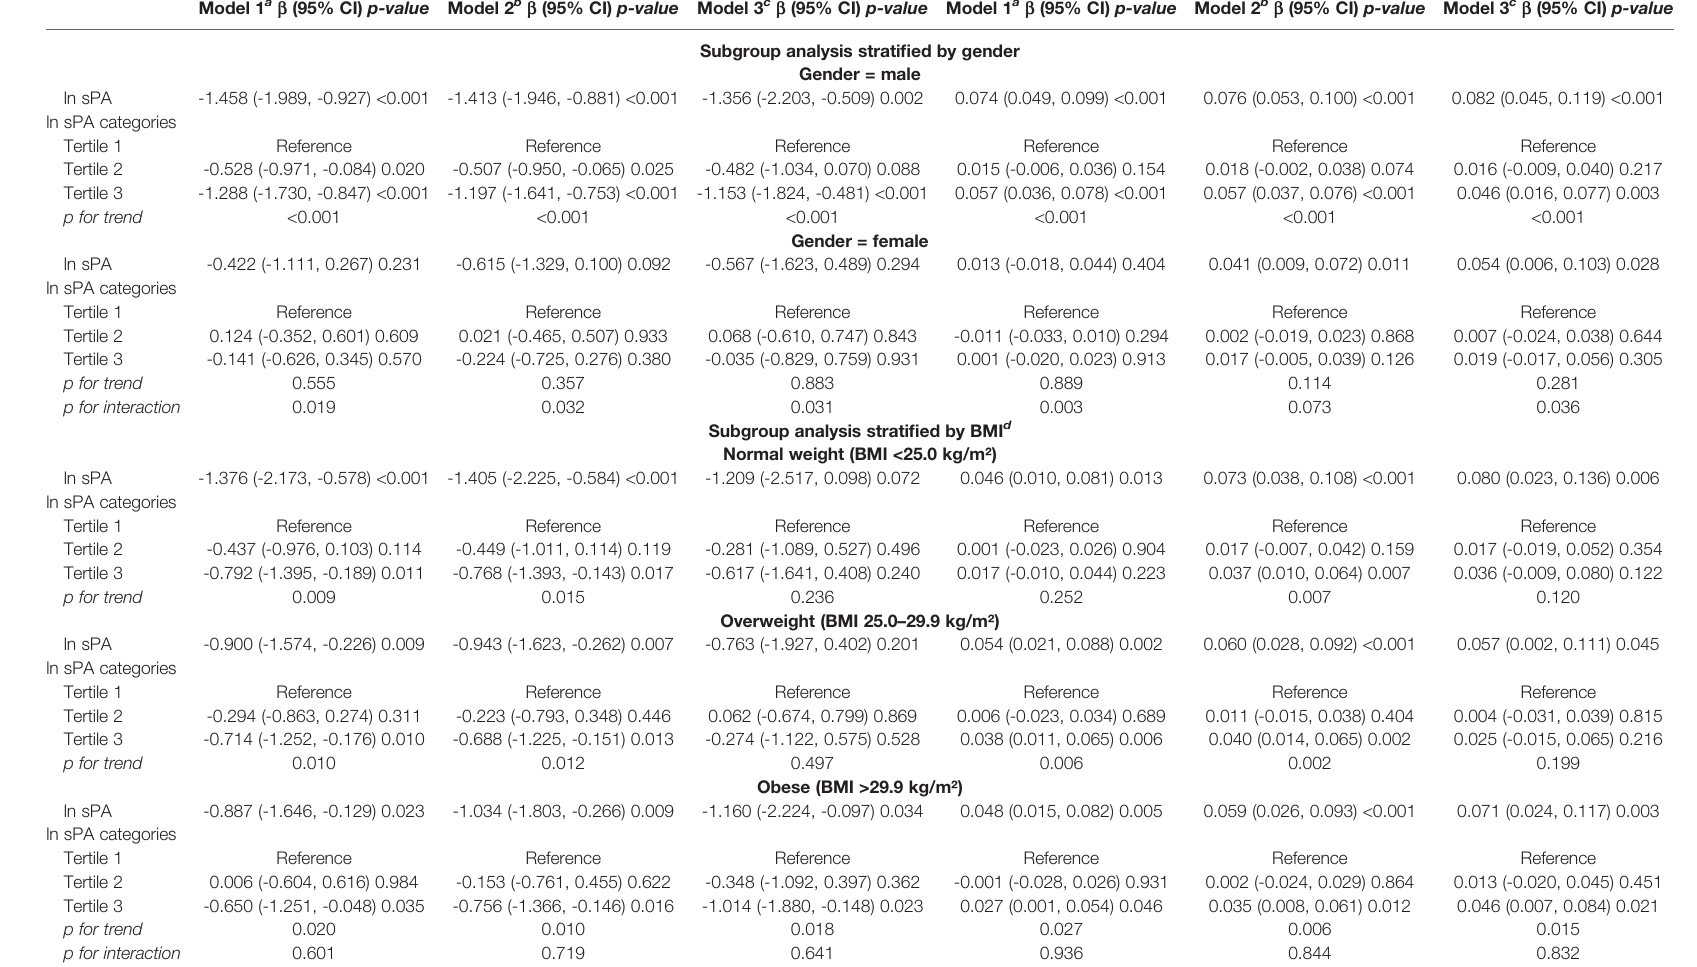
a Model 1: no covariates were adjusted. b Model 2: age, gender, and race/ethnicity were adjusted. c Model 3: age, gender, race/ethnicity, education, marital status, poverty-to-income ratio, mean arterial pressure, body mass index, waist circumference, alcohol use, smoke, alanine aminotransferase, aspartate aminotransferase, total cholesterol, glucose, glycohemoglobin, creatinine, and urine iodin concentration were adjusted. d There were 12 missing data of BMI. FT3, free triiodothyronine; FT4, free thyroxine; sPA, serum palmitic acid; BMI, body mass index; CI, con fi dence